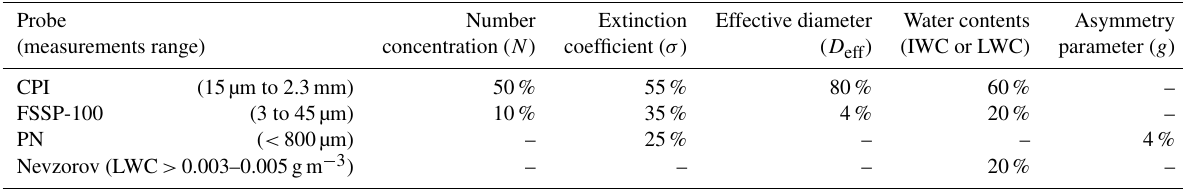
Table 2. Uncertainties of cloud properties derived from CPI, FSSP, PN and Nevzorov instruments. Probe Number